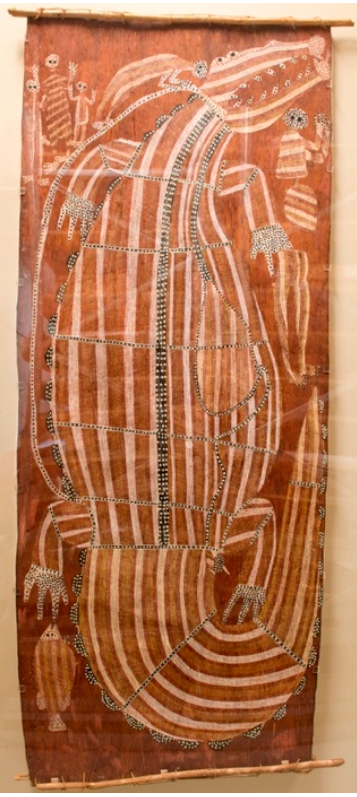
Figure 9. Mick Gubargu, Crocodile Hunting Story , c.1979, 270 cm × 92 cm, Ochre on Bark, image courtesy South Australian Museum, Adelaide. © The estate of the artist licensed by Aboriginal Artists Agency Ltd.